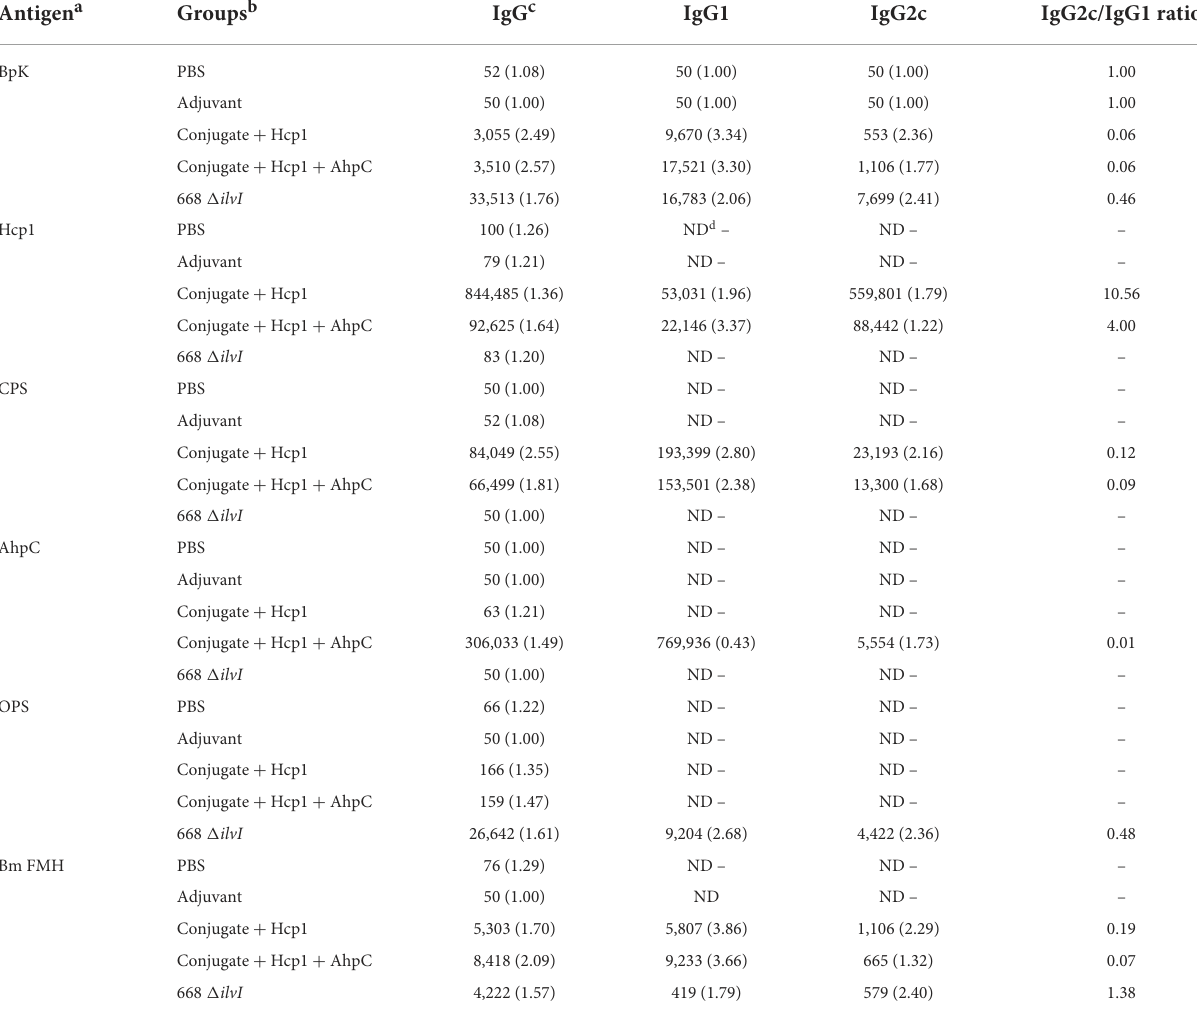
TABLE 3 Total IgG and subclass responses 28 days post-vaccination (day 65) in C57BL/6